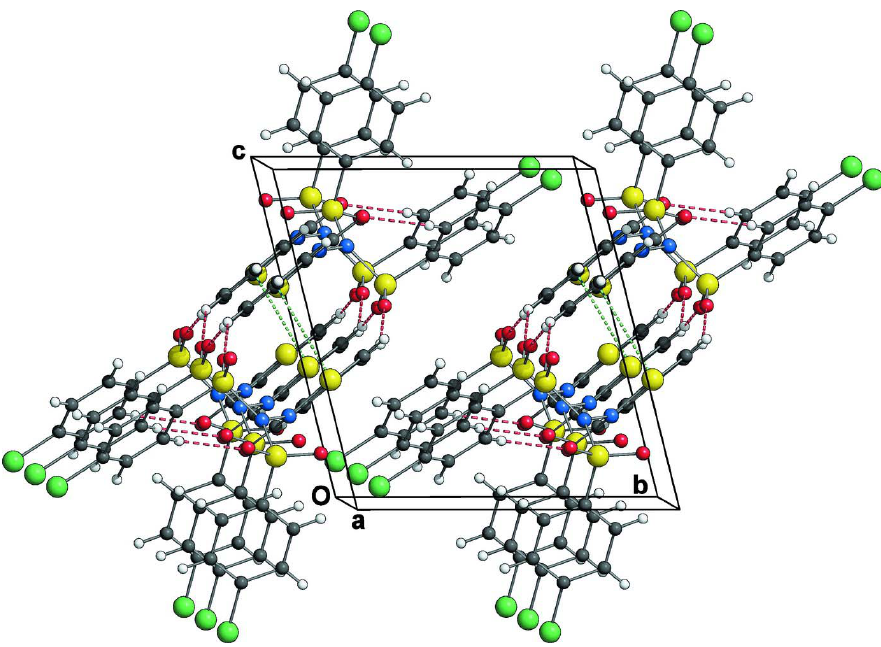
Figure 2 Crystal packing of the title compound viewed approximately along the a axis. Red and green dashed lines indicate C– H···O hydrogen bonds and π - π stacking interactions,